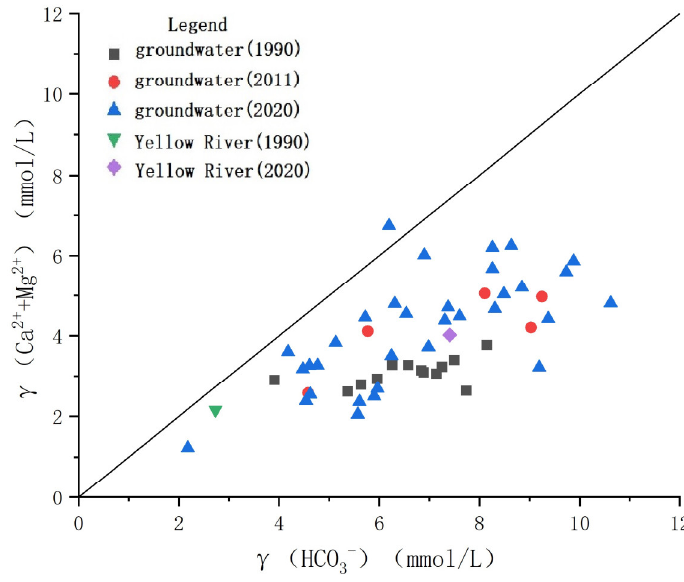
Figure 14. γ(Ca 2+ + Mg 2+ )/γ(HCO 3− ).